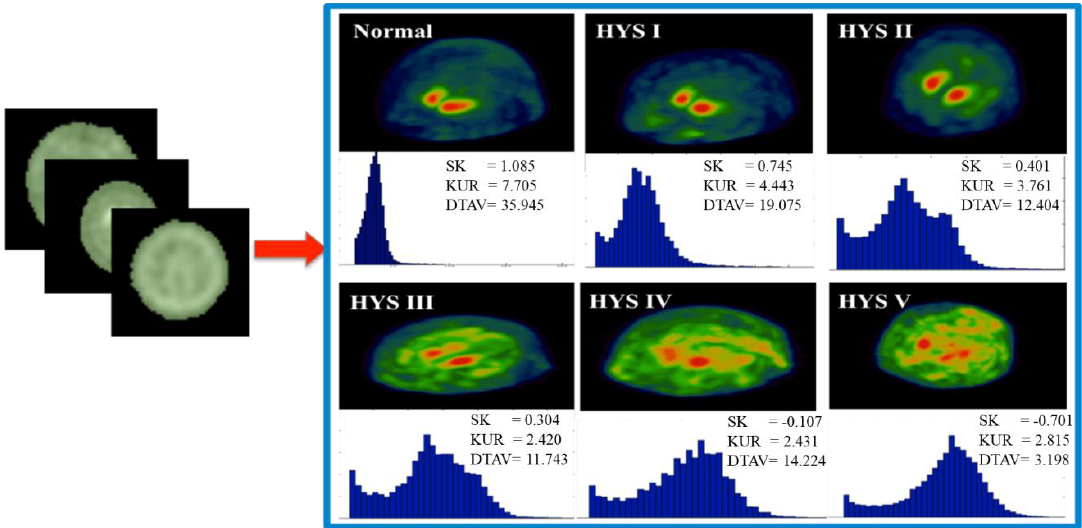
Figure 3. Histogram plots between normal and Parkinson’s Disease (PD) stage. Maximum intensity projection (MIP) shown the calculation of whole brain and correspond to histogram. The histogram can describe active uptake in whole brain via values of skewness (SK).